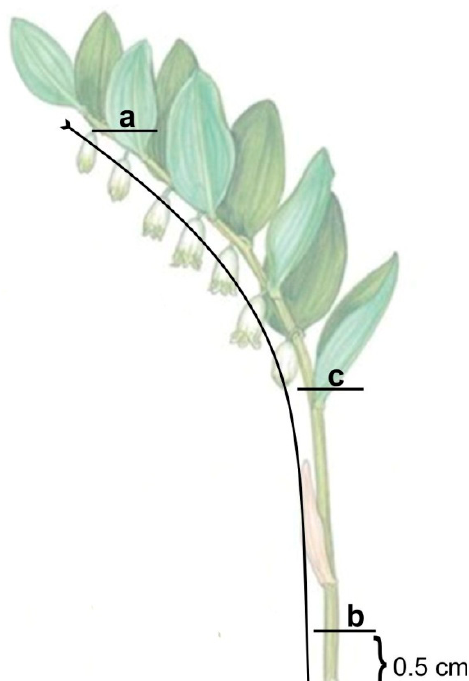
Figure 1. Location of three regions along the length of Polygonatum shoot categorized as basal (b), central (c) and apical (a). Region (b) was 0.5 cm above ground level.